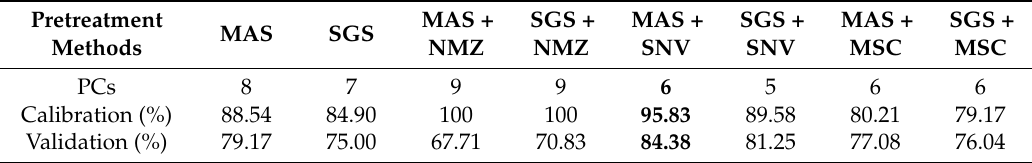
Table 3. Comparison of classification models with different pretreatment methods based on the mixture of kernel samples orientated with germ up and